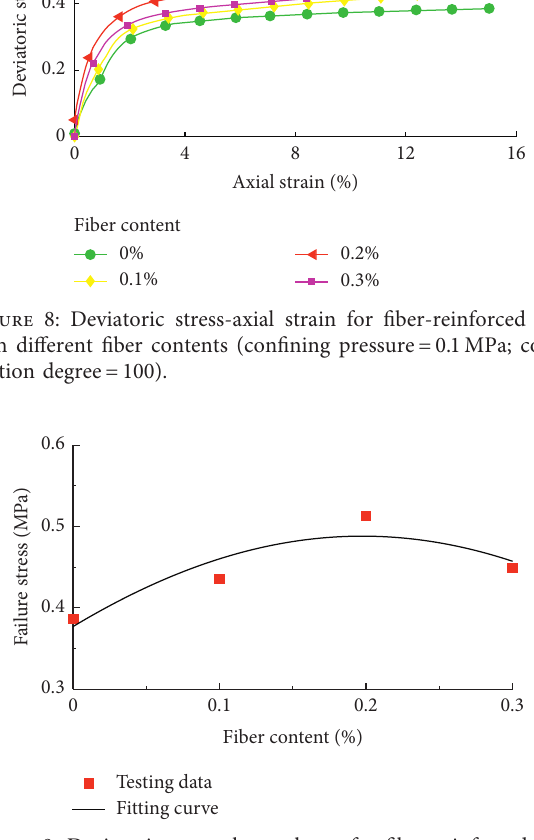
Figure 9: Deviatoric strength envelopes for fiber-reinforced soil with different fiber contents (confining pressure � 0.1 MPa; com- paction degree � 100).